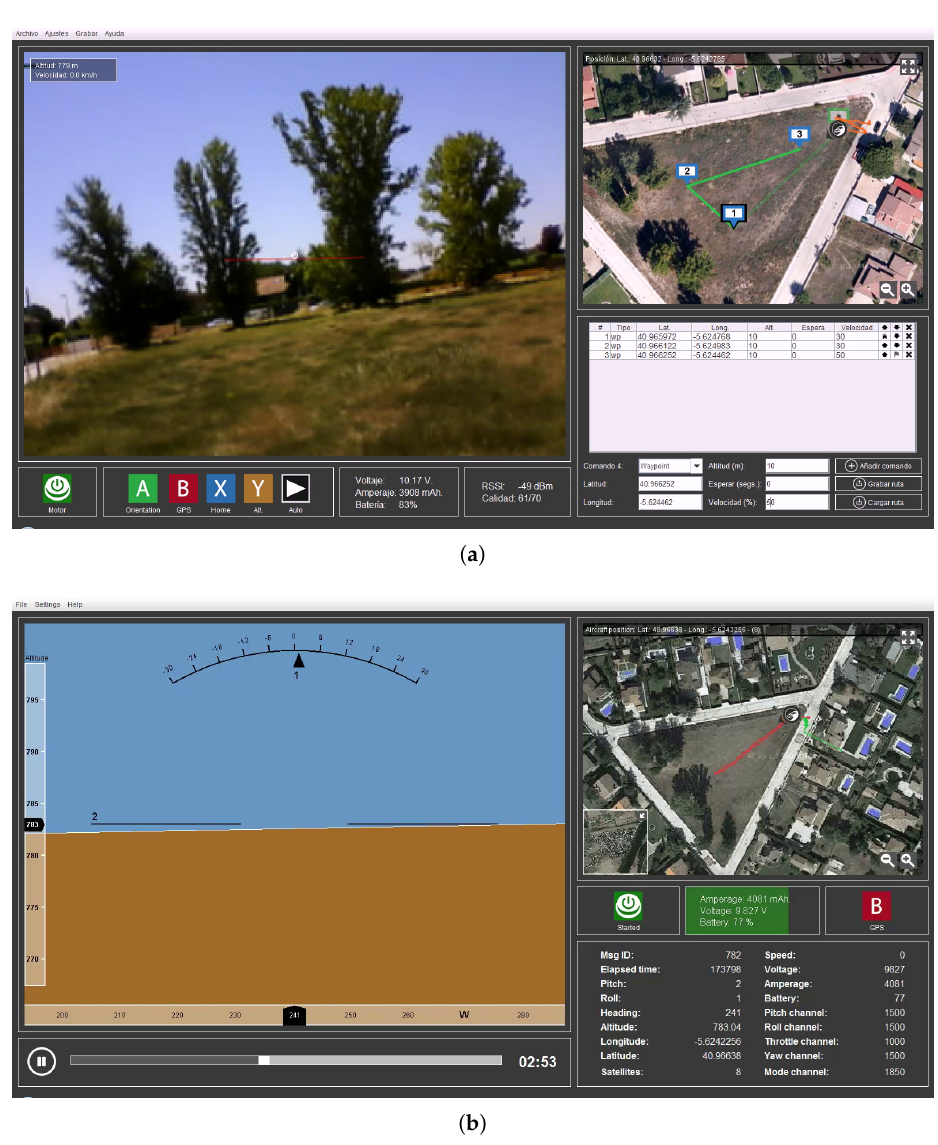
Figure 2. Developed software: ( a ) ground control station; and ( b ) recorded telemetry